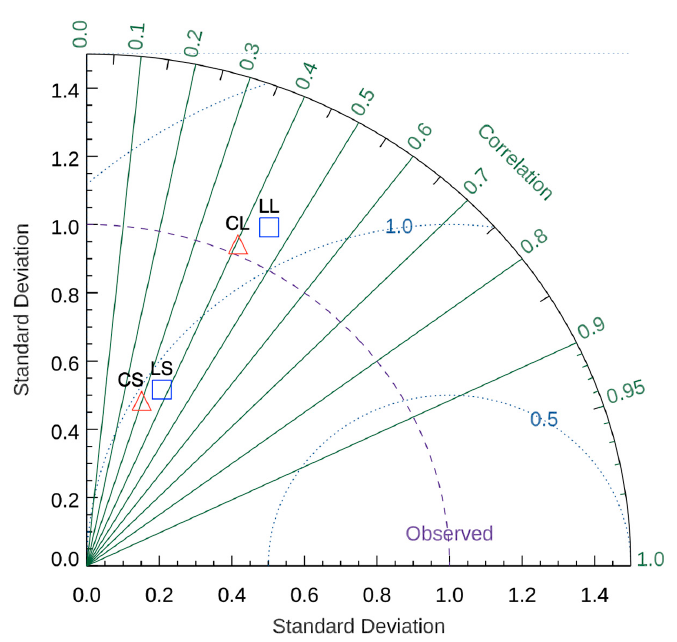
Figure 5. Taylor diagram for CTRL (red triangles) and LIGHT (blue squares) forecasts for land and sea. CS (CL) is for the CTRL forecast over the sea (over land) and LS (LL) is for the LIGHT forecast over the sea (over land).